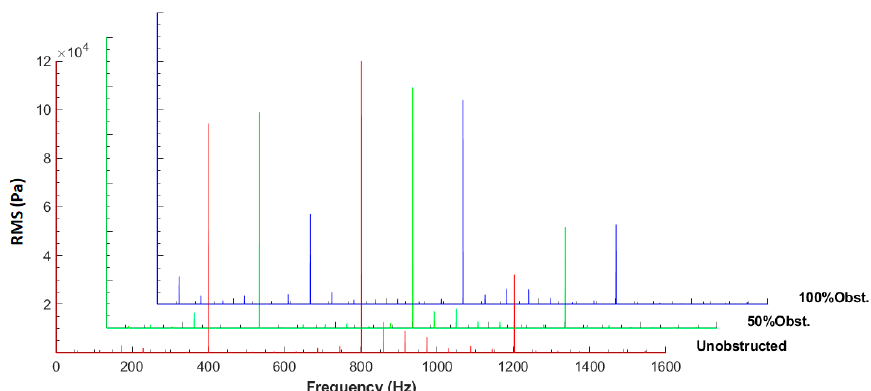
Figure 20. Frequency spectra in the inertial reference frame (monitor point E1) for different distributor blockage sizes.